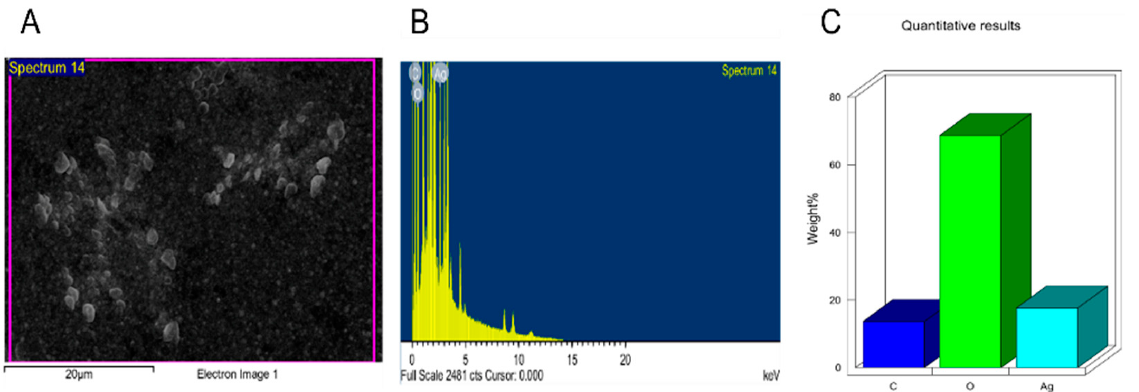
Figure 8. Surface morphology of R-AgNPs ( A ) and quantitative data analysis of images and describing the weights of the of carbon, oxygen and silver atoms using EDS ( B , C ).